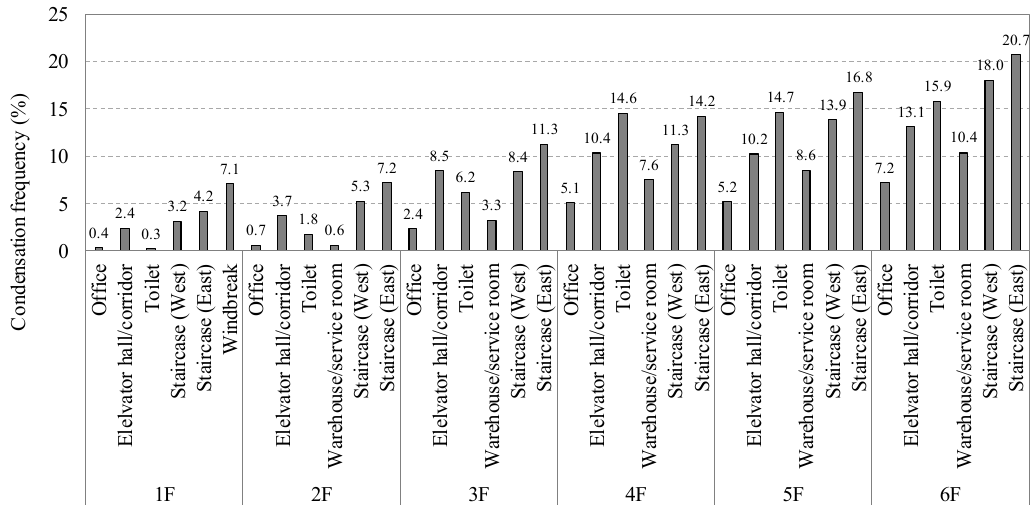
Figure 13. Condensation frequency for the windows in each zone (thermal insulation of external wall = 75 mm, thermal insulation of the roof = 105 mm).